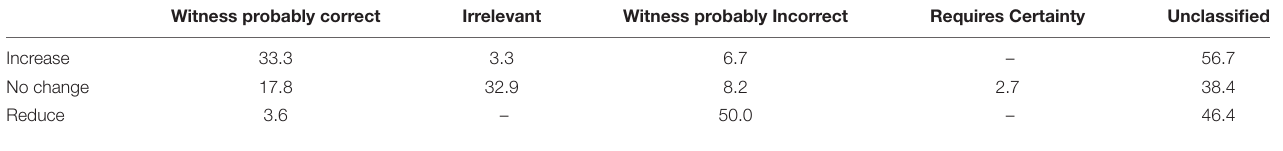
TABLE 2 | Percentages of each response type assigned each code type (modal code excluding ‘unclassified’ is highlighted for each